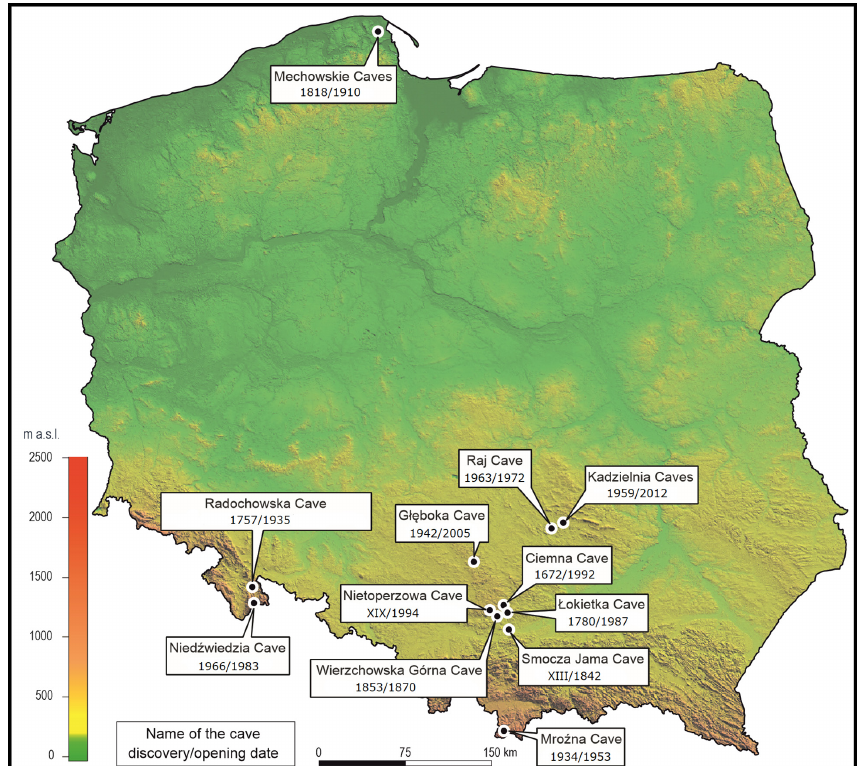
Fig. 1. Location of show caves on the digital elevation model of Poland.